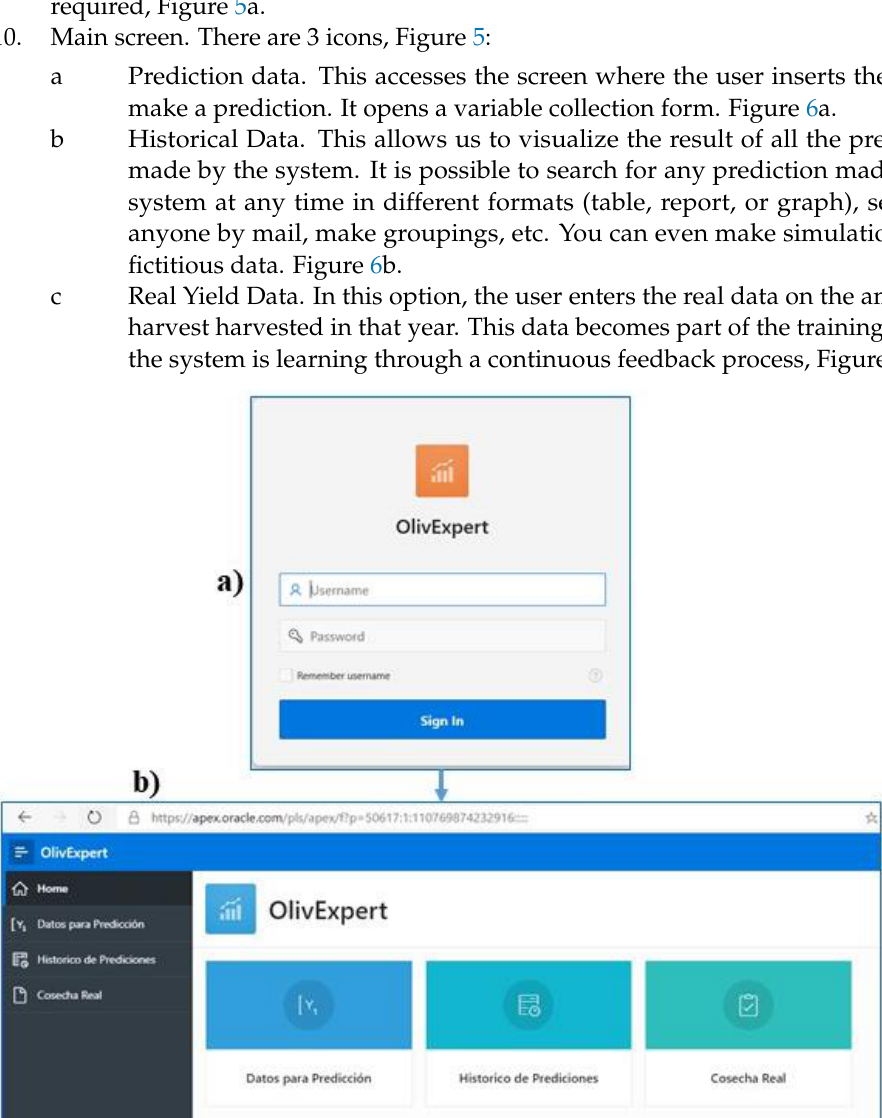
Figure 5. Interface of the web application, ( a ) login; ( b ) main